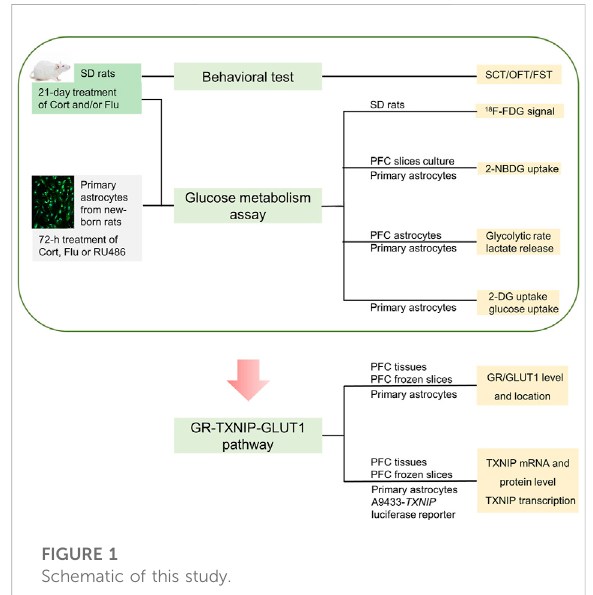
FIGURE 1 Schematic of this